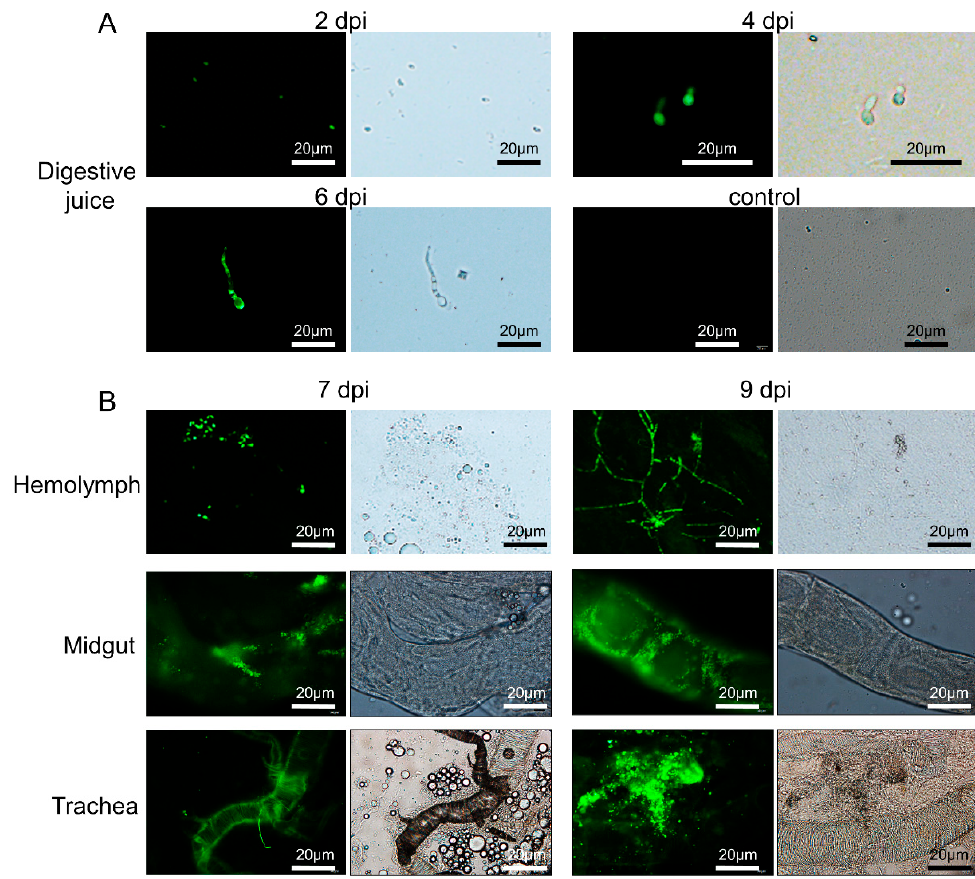
Figure 5. Invasion process of C. farinosa via the digestive tract. ( A ) Observation of larval digestive juice at different time points after infection. Uninfected larvae as control ( B ) Observation of larval tissues at different time points after infection. The green fluorescent signal represents the transgenic C. farinosa . dpi: days post-infection.